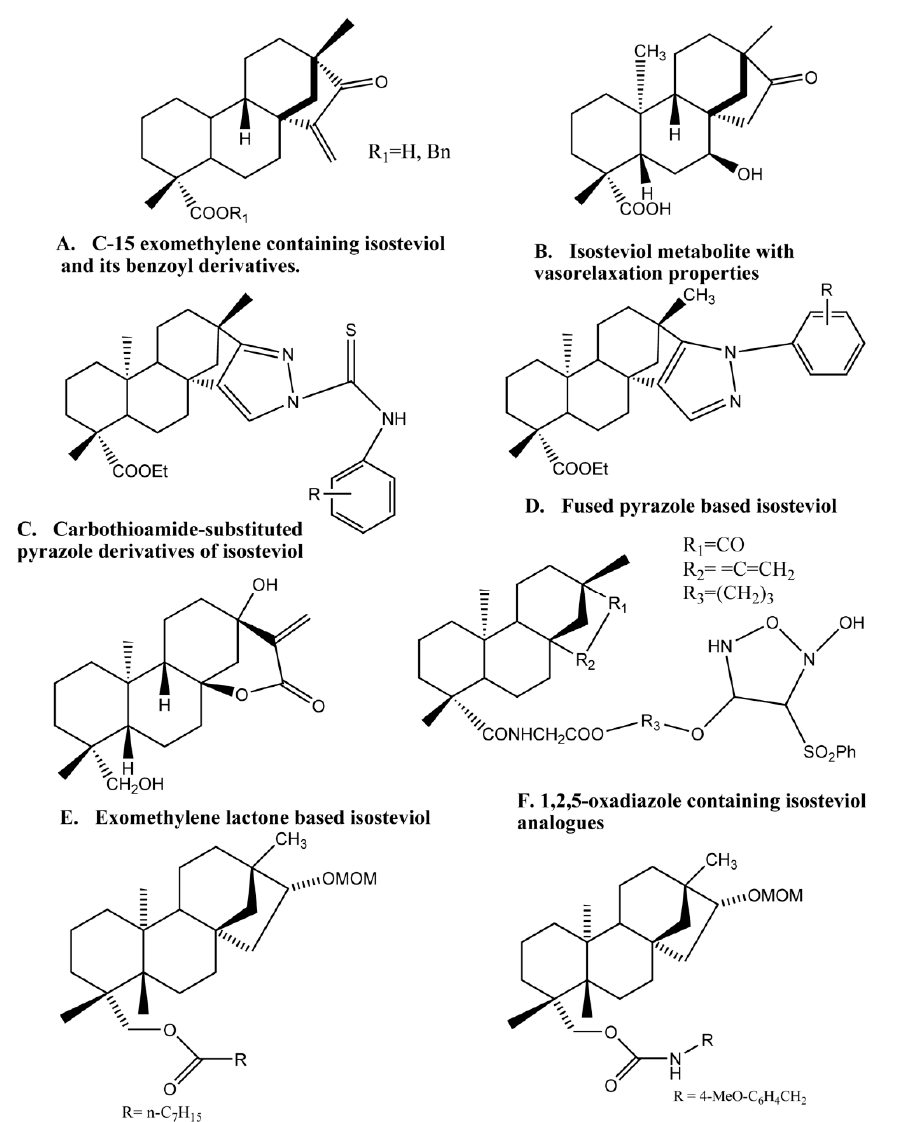
Figure 2. Bioactive derivatives of isosteviol.